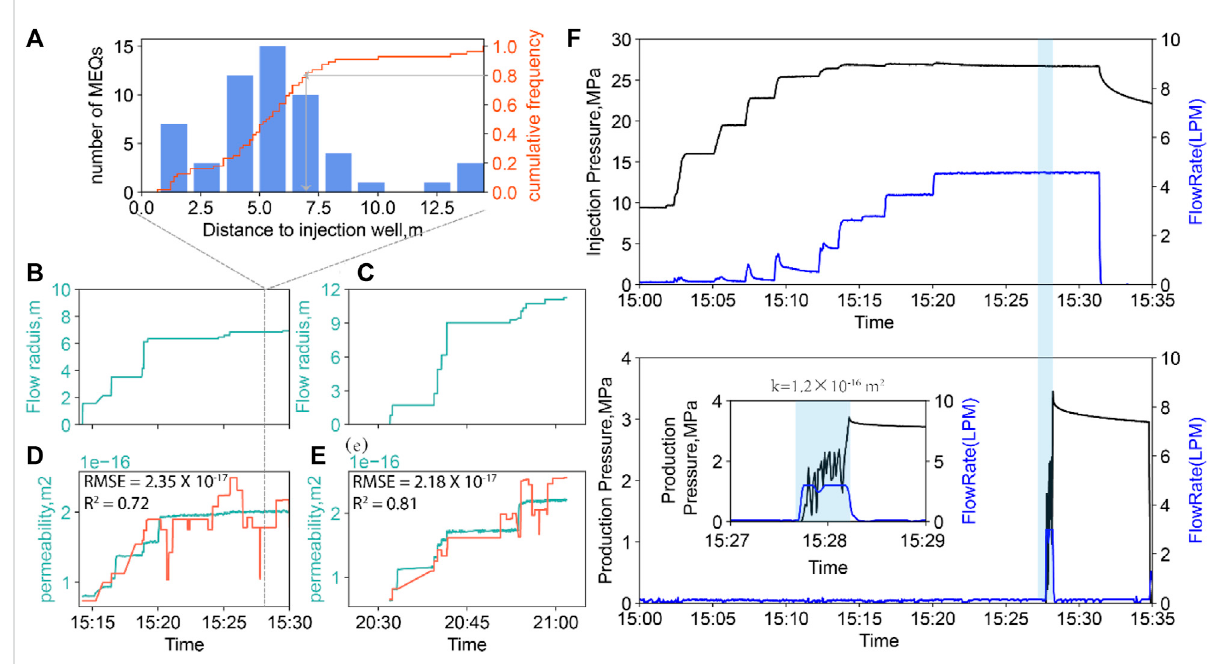
FIGURE 3 Deterministic permeability calculation and validation. (A) Illustration fi gure shows the fl ow radius estimated by the cumulative frequency of MEQs of 0.8 at the time T. Figure (B) and (C) show the evolution of the fl ow radius for episodes #4 and #5. (D) and (E) show the ground truth (light green line) and ML-predicted (orange line) permeabilities for episodes #4 and #5. (F) Top: pressure (black line) and injection fl ow rate (blue line) histories for episode #4. Bottom: pressure (black line) and fl ow rate (blue line) histories of the production well for episode #4. Insert fi gure shows the zoom in of the light blue shade area, where permeability is calculated and further used to validate the ground truth of permeability calculated by injectivity based on the cylindrical fl ow